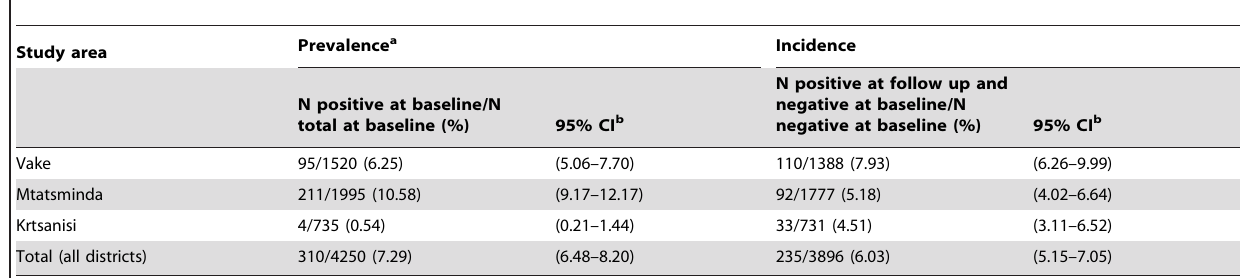
Table 1. Baseline prevalence and annual incidence (one year follow-up) of Leishmania seropositivity in surveyed children.